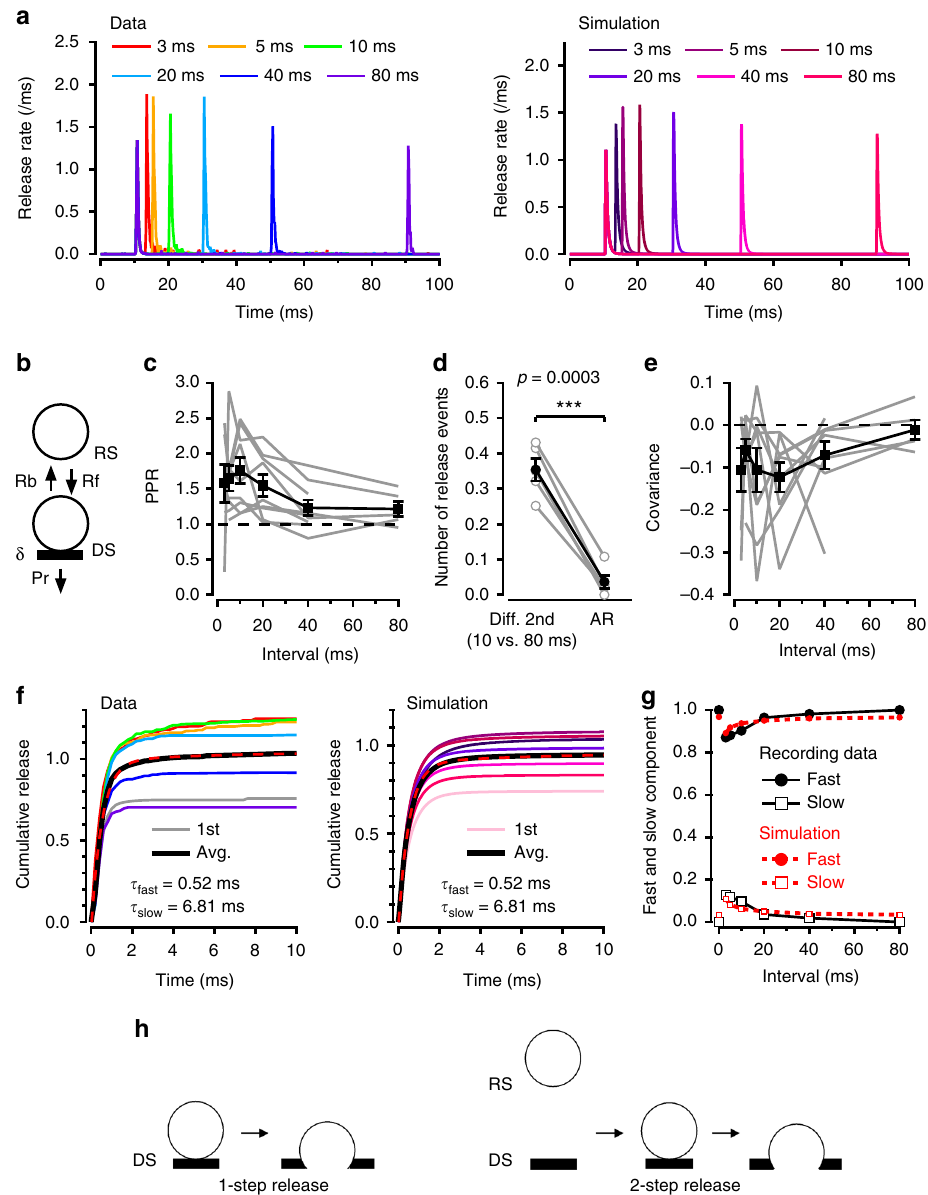
Fig. 2 Facilitation and slow latency component in paired stimulation experiments. a Pairs of APs with variable inter-AP intervals (from 3 to 80 ms) were applied cyclically (with 10 s intervals between pairs), and release rates were calculated per AZ. Averaging across experiments indicates a transient facilitation peaking near 10 ms and decaying back to control over 80 ms (left). Right: Corresponding simulation. b Model of docking/undocking processes for four docking sites per AZ, where each docking site (DS) is associated with a replacement site (RS), with docking rate R f and undocking rate R b . c Experimental PPR values (where PPR is calculated from the mean numbers s 1 and s 2 of released SVs for the two stimuli) for nine experiments (black squares: mean ± sem; grey: individual experiments). d Asynchronous release cannot account for facilitation recovery. In each experiment, the difference between mean SV numbers observed after 10 vs. 80 ms was larger than the amount of asynchronous release occurring 10 – 80 ms after one AP, showing that the recovery of δ cannot be explained on the basis of delayed exocytosis (P r in scheme b ). Error bars show sem (grey: individual experiments; n = 5). Two-tailed paired t test, t (4) = 12.1, *** p < 0.001. e Covariance between s 1 and s 2 , as a function of inter-AP interval. f Cumulative plots of experimental (left; average of nine experiments) and simulated (right) latencies for fi rst latencies as well as for second latencies with different inter-AP intervals (colour code as in a ). Note that facilitation is accompanied with the appearance of a secondary slow latency component. Average data of fi rst and all second responses are fi tted in both experimental and simulated distributions with the sum of two exponentials with time constants τ fast and τ slow . g Plot of τ fast and τ slow component amplitudes as a function of inter-AP interval (black: experimental; red: simulation). h Two different SV release modes. Left: 1-step release shows the classical view of release of a docked SV following AP stimulation. Right: 2-step release shows a rapid sequence of docking (RS → DS)